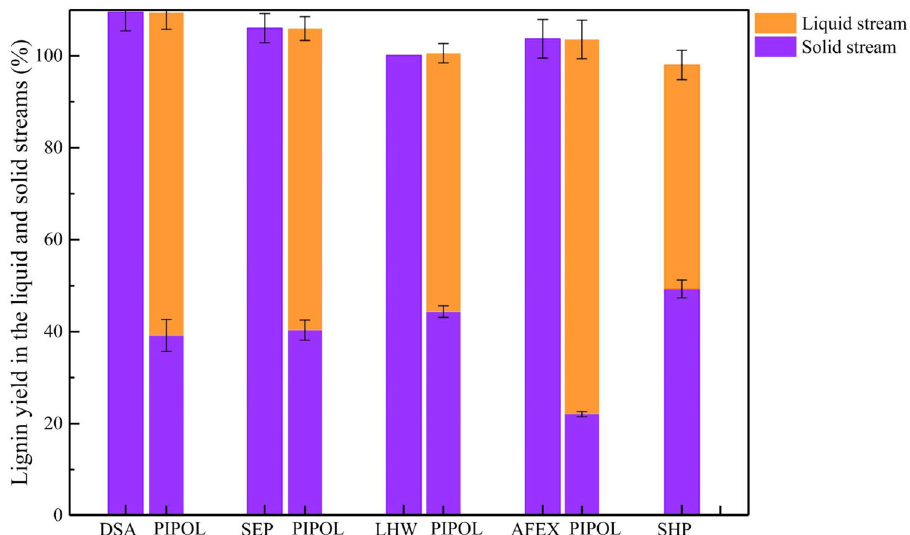
Fig. 2 The lignin yield in the solid and liquid streams by ‘ plug-in processes of lignin (PIPOL) ’ . DSA dilute sulfuric acid pretreatment, SEP steam explosion pretreatment, LHW liquid hot water pretreatment, AFEX ammonia fi ber expansion, SHP sodium hydroxide pretreatment. The conditions of leading pretreatment were provided in Supplementary Table 1. Error bars represent the standard deviation.